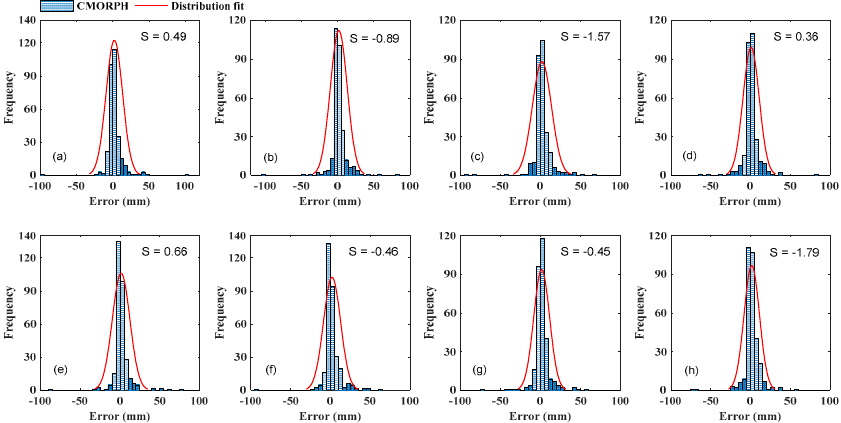
Figure 11. The histogram of daily rainfall error distribution for CMORPH.